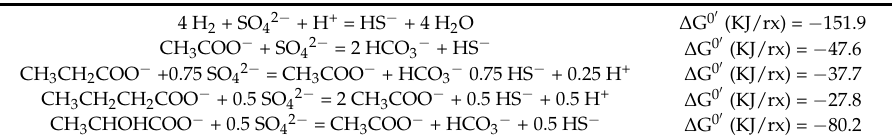
Table 1. Redox reactions for the formation of hydrogen sulfide by sulfate-reducing bacteria in the presence of exemplary electron donors and electron